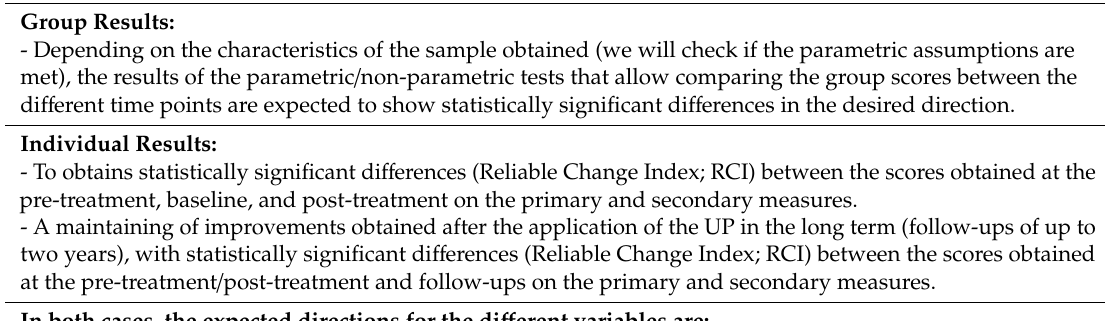
Table 4. Main expected outcomes. UP: Unified Protocol for the transdiagnostic Treatment of Eds. Clinical Usefulness of the UP for Bariatric Surgery